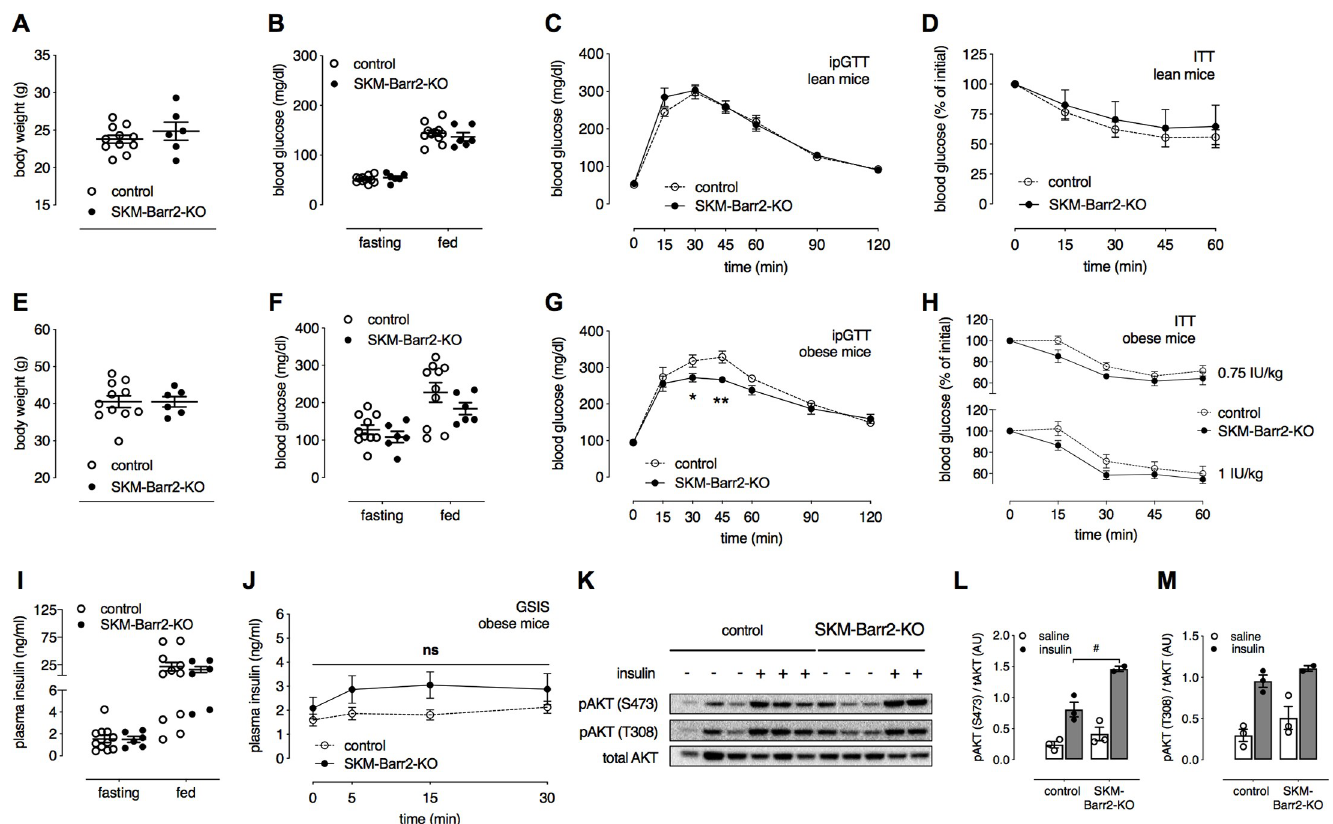
Fig 2. HFD SKM-Barr2-KO mice show improved glucose tolerance. All experiments were carried out with SKM-Barr2-KO mice and their control littermates (adult males) maintained on regular chow (A-D) or a high-fat diet (HFD) for at least 8 weeks (E-M). (A, E) Body weights. (B, F) Fasting and fed blood glucose levels. (C, G) I. p. glucose tolerance test (ipGTT). (D, H) Insulin tolerance test (ITT). Initial blood glucose levels were set to 100% (actual basal blood glucose levels were (in mg/dl): 144 ± 6 vs. 137 ± 9 (D) and 165 ± 7 vs. 177 ± 7 (H, upper panel) and 183 ± 30 vs. 222 ± 16 (H, lower panel) for control vs. SKM-Barr2-KO mice, respectively). (I) Fasting and fed plasma insulin levels. (J) Glucose-stimulated insulin secretion (GSIS). Data are shown as mean ± SEM (6–11 mice per group). � P < 0.05, �� P < 0.01 (Student’s unpaired t-test). (K-M) Western blotting studies examining AKT phosphorylation. HFD mice were fasted for 2 h and injected with saline (-) or insulin (0.75 IU/kg). Quadriceps muscles were isolated 10 min later, and protein lysates were used for western blotting studies. (L, M) Quantification of the Western blotting data shown in (K). Data are presented as mean ± SEM. #P < 0.01 (2-way-ANOVA). Ns, no statistically significant difference (2-way-ANOVA).